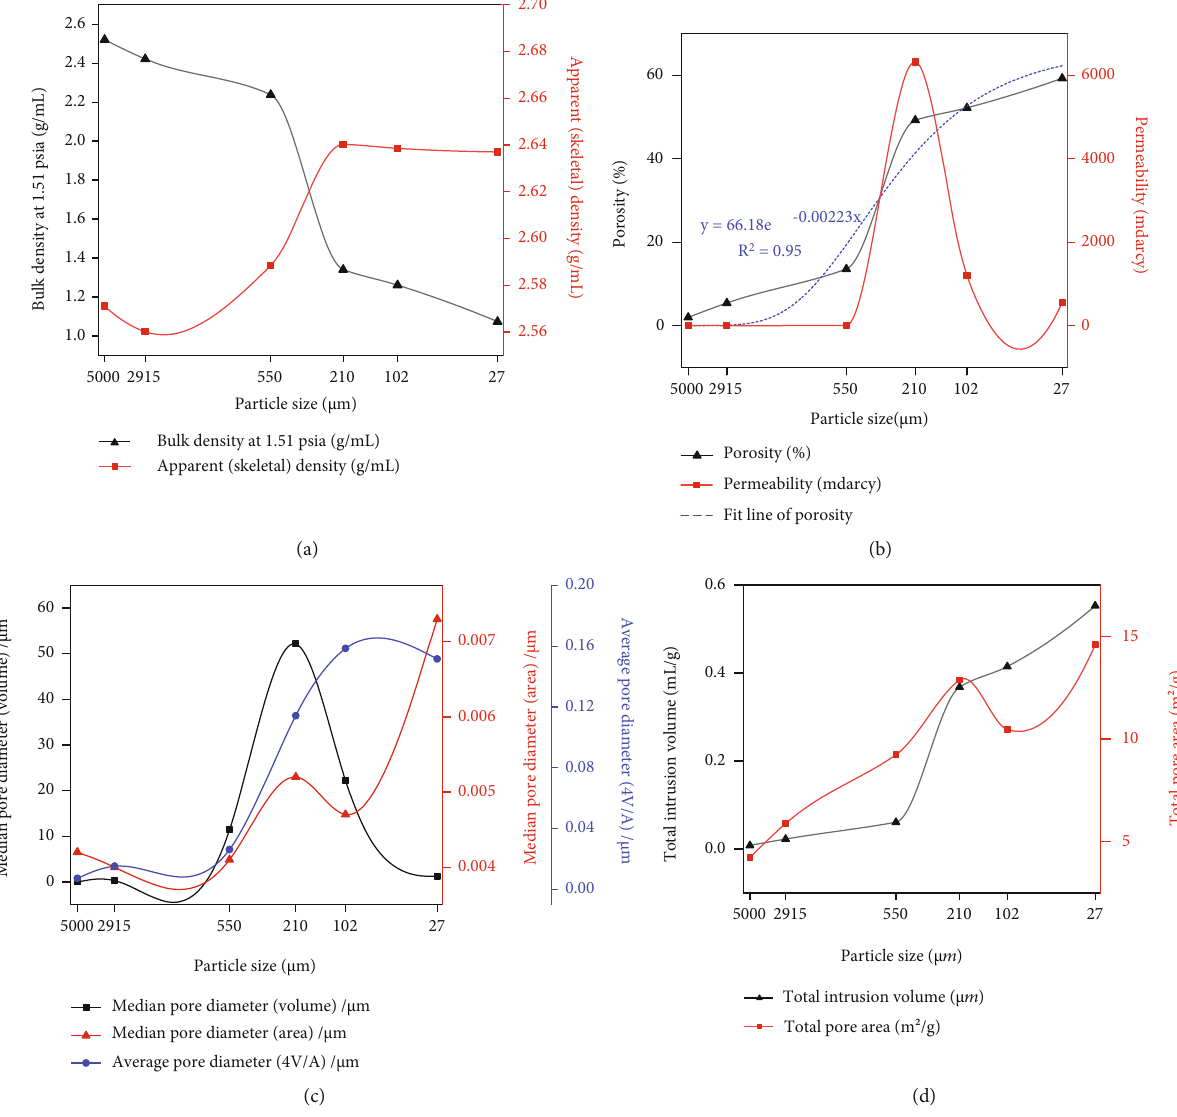
Figure 11: The relationship between pore structure parameters and particle size: (a) skeletal density and bulk density; (b) porosity and permeability calculated according to Katz and Thompson (1986); (c) median pore diameter and average pore diameter; (d) total mercury intrusion volume and total pore